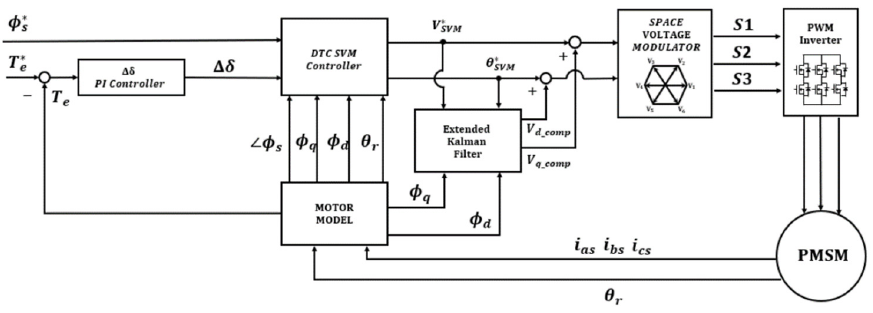
Figure 12. DTC-SVM control block diagram applying the proposed extended Kalman filter-based disturbance observer .